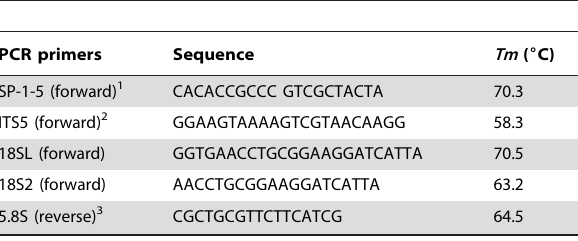
Table 1. Sequences and melting temperature ( Tm ) of PCR primers used in this